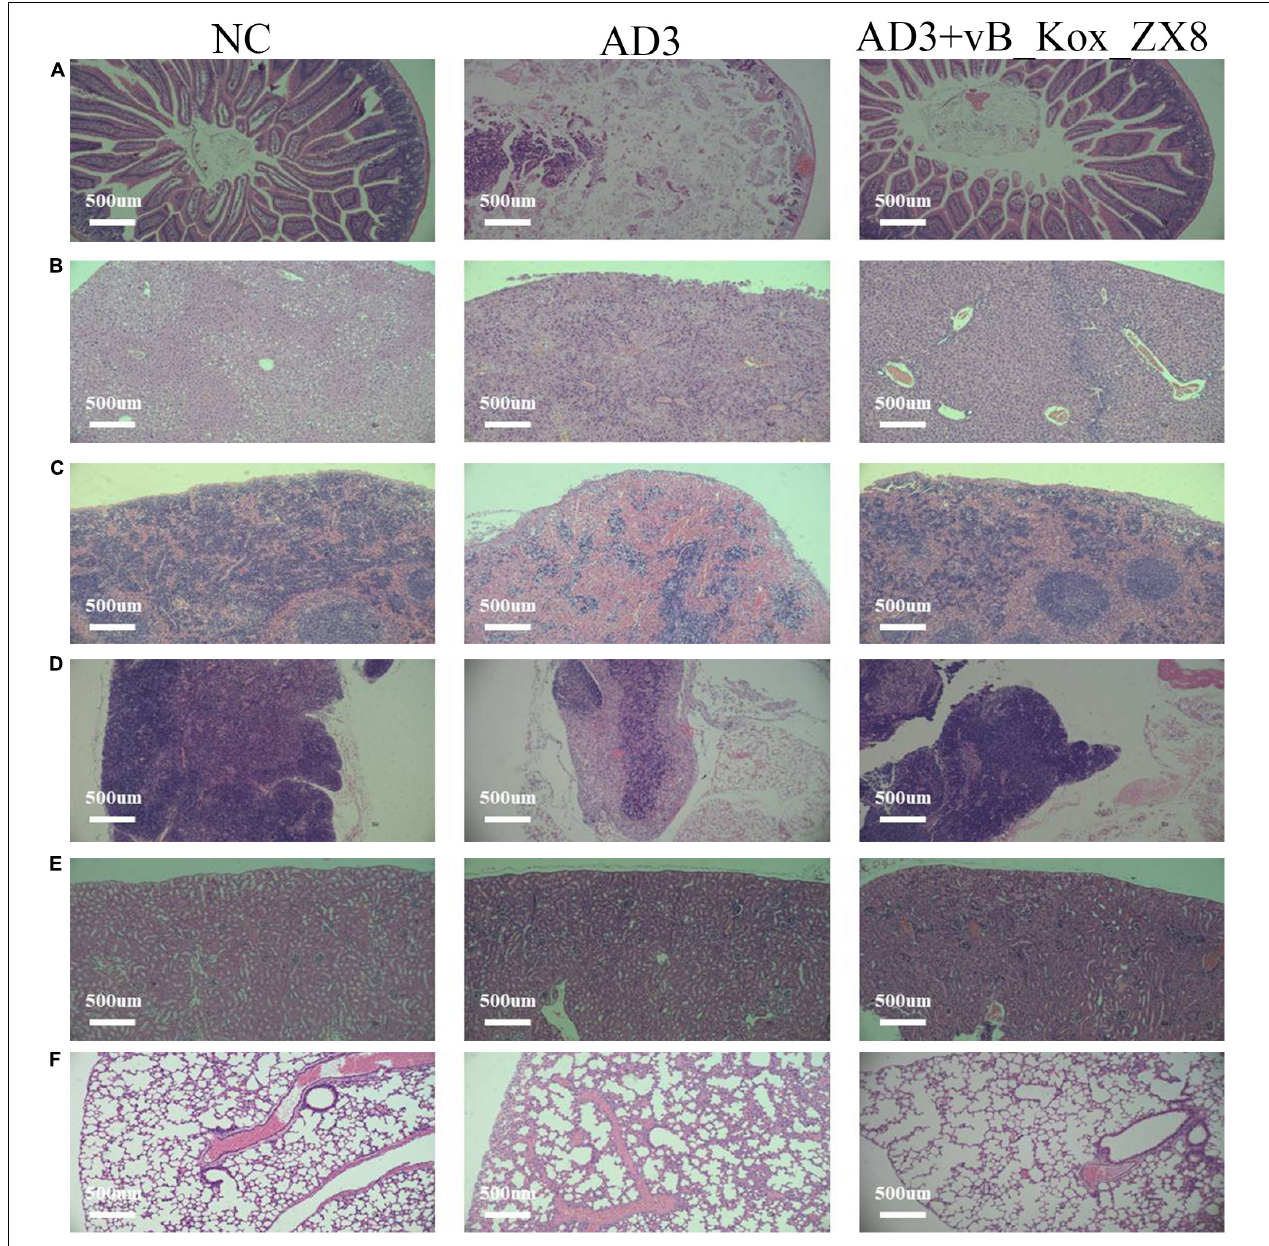
FIGURE 9 | Pathological sections of the (A) small intestine, (B) liver, (C) spleen, (D) thymus, (E) kidney, and (F) lung in mice after 48 h rescued by phage vB_Kox_ZX8. Each mouse was injected with 5 × 10 6 CFU of K. oxytoca AD3 and 5 × 10 7 PFU of phage vB_Kox_ZX8, and the uninjected control